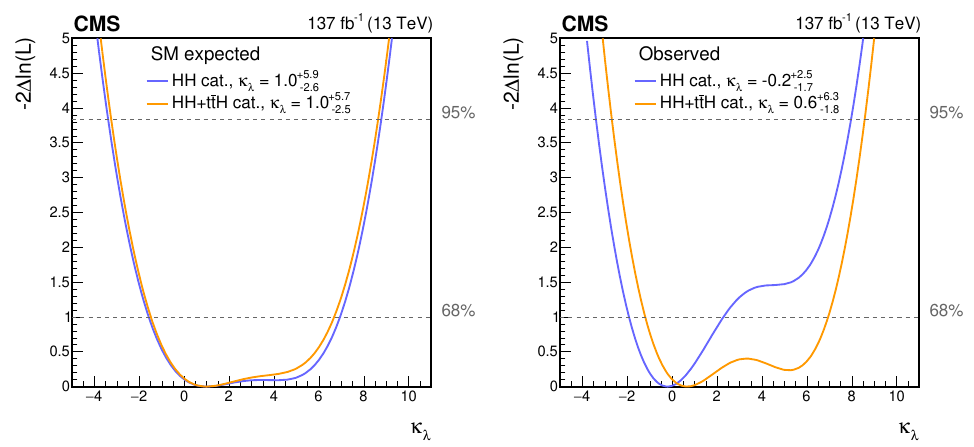
, evaluated with an Asimov data set assuming Figure 11 . Negative log-likelihood, as a function of κ λ the SM hypothesis (left) and the observed data (right). The 68 and 95% CL intervals are shown with the dashed gray lines. The two curves are shown for the HH (blue) and HH + ttH (orange) analysis categories. All other couplings are set to their SM